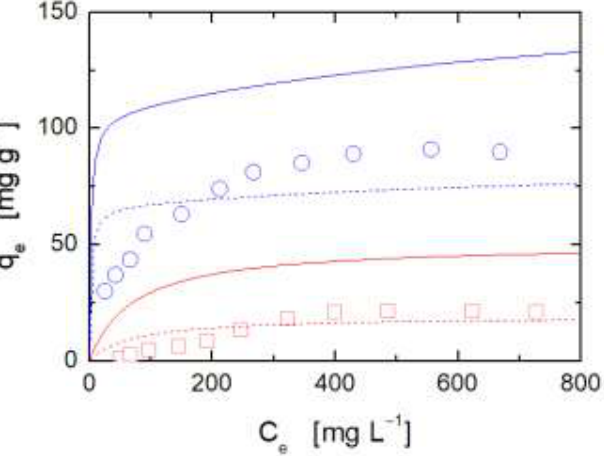
Figure 6. Adsorption isotherms at 25 °C of anionic dye IC (blue circles) and cationic dye RH (red squares) for hybrid CS/LTA aerogel at weight ratio equal to 1:1. Solid lines correspond to Equation (3), and dashed lines represent the best fitting with Equation (4). In both cases, Langmuir model parameters of pristine CS and LTA reported in Table 1 have been considered.